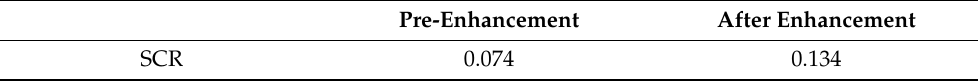
Table 2. Signal-to-noise ratios (SCRs) before and after small-target enhancement.